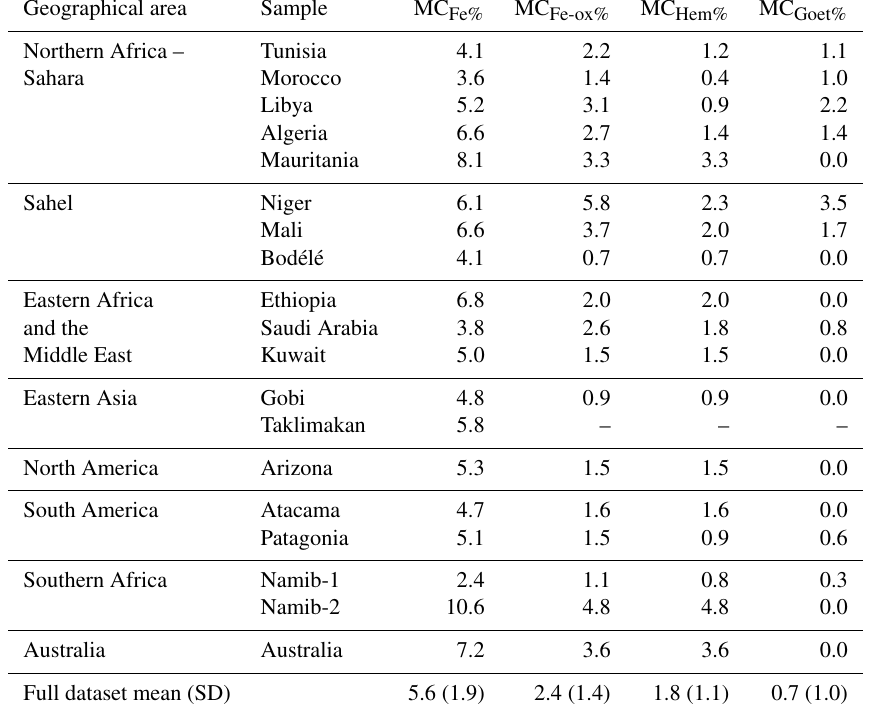
Table 3. Chemical characterization of the dust aerosols in the PM 10 . 6 size fraction. Column 3 shows MC Fe% , the fractional mass of elemental iron with respect to the total dust mass concentration ( ± 10% relative uncertainty), and column 4 reports MC Fe-ox% , the mass fraction of iron oxides with respect to the total dust mass concentration ( ± 15% relative uncertainty) and its speciation in hematite MC Hem% and goethite MC Goeth% (< ± 10% relative uncertainty). The iron oxide measurements were not made on the Taklimakan sample. Mean values and standard deviations (SDs) based on single-sample data are reported for the full